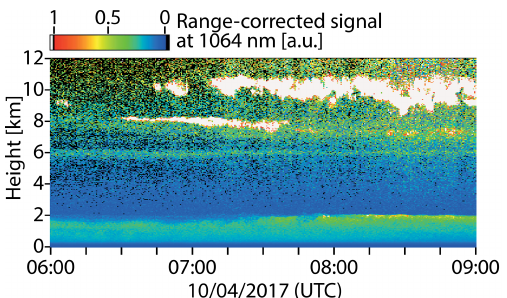
Figure 7. Development of a thin cirrus at 8km height at 06:30UTC on 10 April 2017. The thin cirrus layer was embedded in Saharan dust. An extended cirrus field is visible from 9 to 11km height. The polluted boundary layer reached to about 2km height. Ranged- corrected 1064nm lidar signals are shown with 7.5m and 30s res- olution.